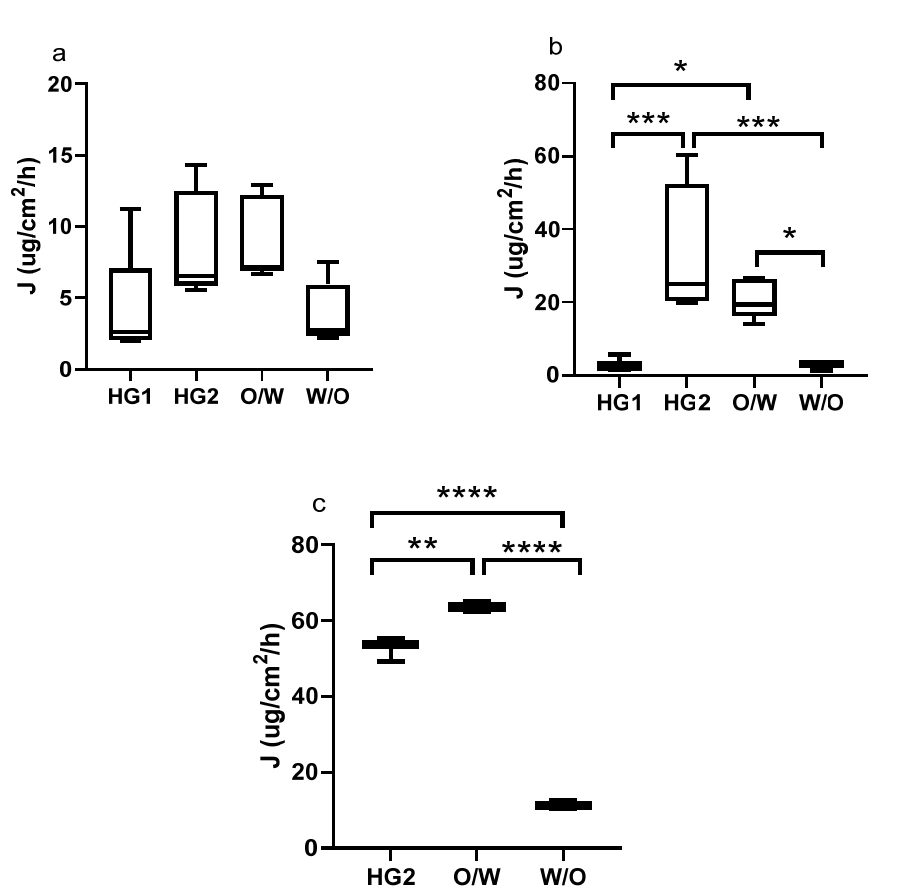
Figure 3. Box diagrams of release rate (Flux, J) from different formulations using HSE ( a ), Strat-M ( b ), and Skin PAMPA ( c ) membranes. (* p < 0.05, ** p < 0.01, *** p < 0.001, **** p < 0.0001, ns: no significance).